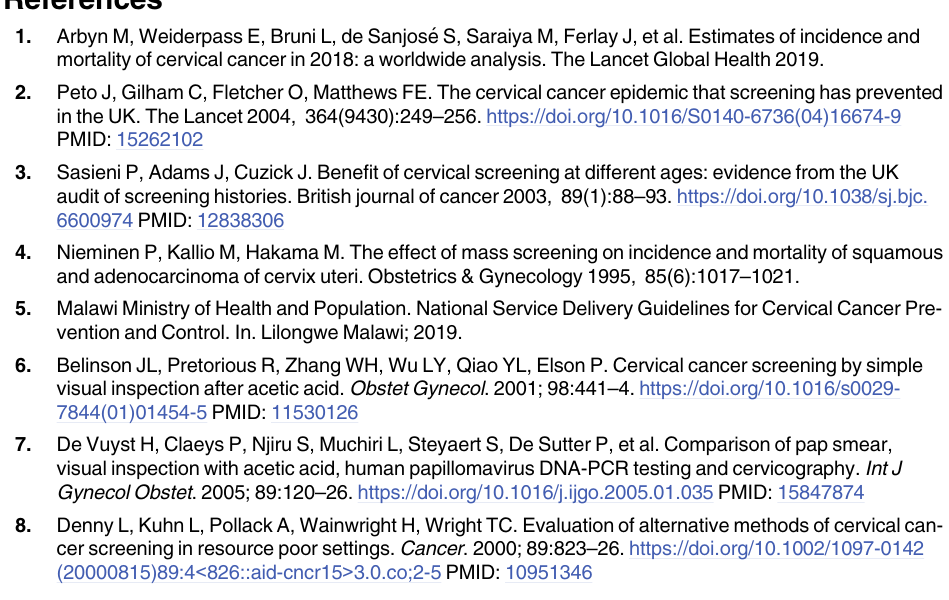
S1 Table. Association between HIV status and VIA outcomes among women screened for the first time (n =